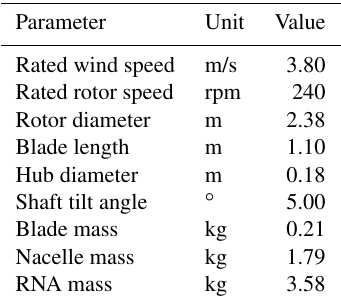
Table 2. Specifications of the wind-turbine-scale model (RNA stands for rotor–nacelle